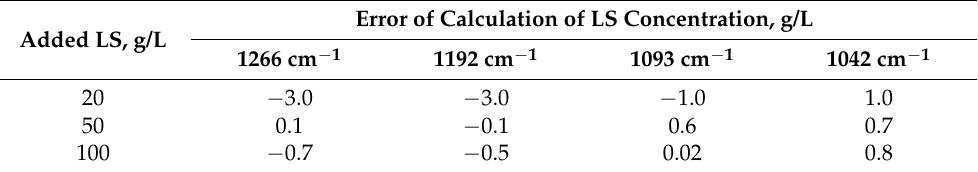
Table 4. Error in determining lignosulfonate in neat solutions ( n = 6, p = 0.95).